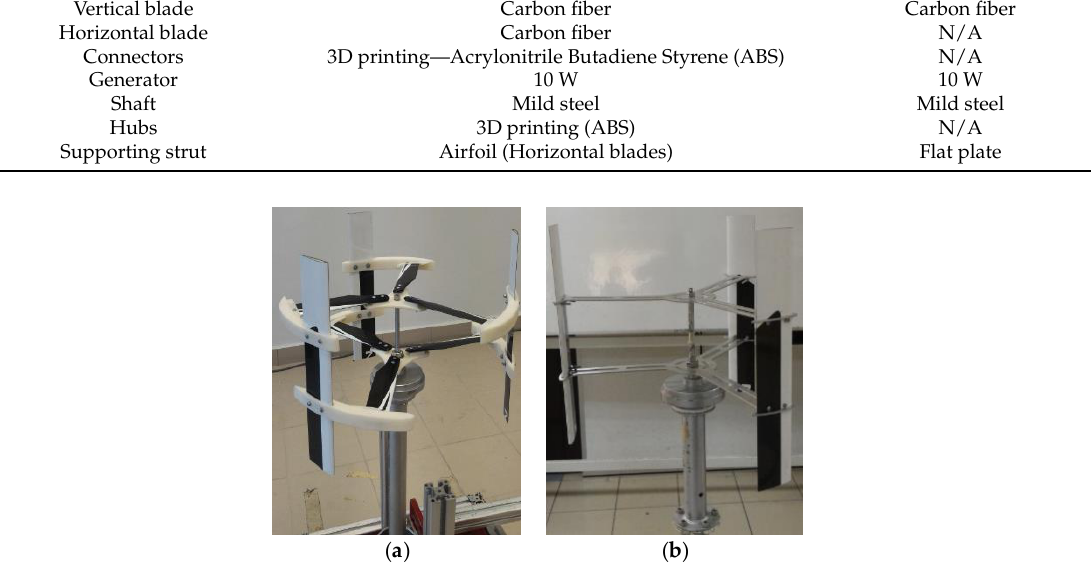
Figure 4. Lab scale model of: ( a ) CAWT; and ( b ) VAWT. Table 2. Summary of design parameters of the lab scale CAWT and straight-bladed VAWT.